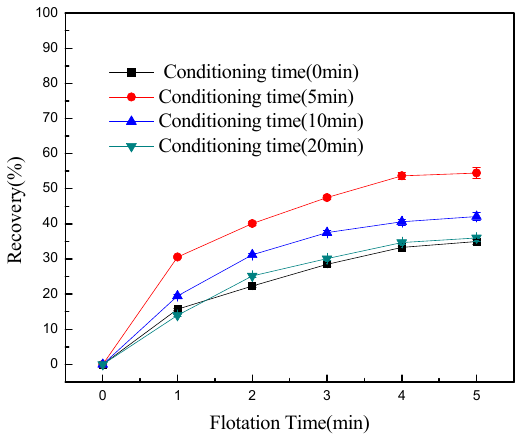
Figure 7. Effect of conditioning time under natural atmosphere on the recovery of mixed minerals, with pyrrhotite and chlorite mixed at a ratio of 10:1 (pH = 9.0 ± 0.2; C(potassium amyl xanthate) = 1 × 10 − 4 mol/L; C(MIBC) = 1 × 10 − 4 mol/L; and Conditioning time = 5 min).